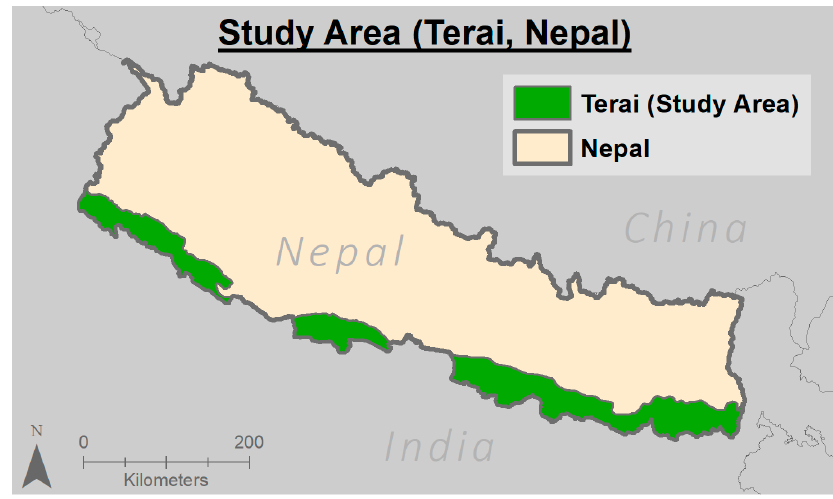
Figure 1. Study area map of Terai region of Nepal.